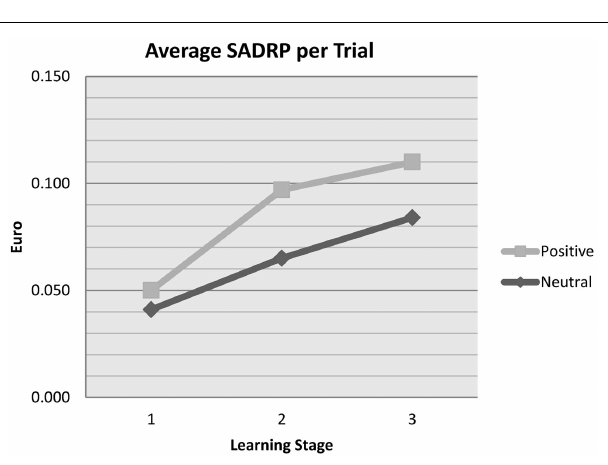
FIGURE 4 |Average SADRP values per trial, separately for eachAffect group, during stages 1 (trial 1–20), 2 (trial 21–40), and 3 (trial 41–60) of learning, collapsed across the 90:10 and 80:20